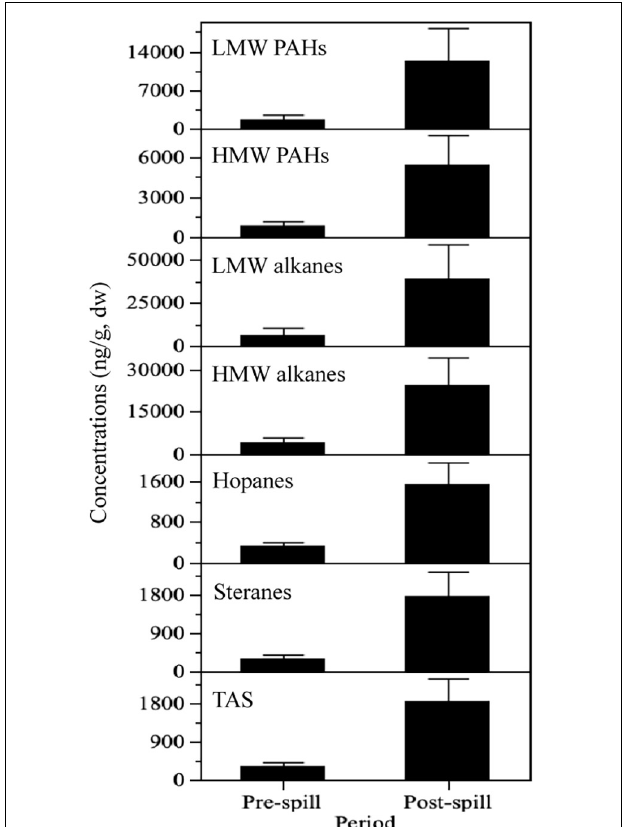
FIGURE 2 | Hydrocarbon concentrations (ng/g, dw) by periods from sediment samples collected in 2010–2011 in the nGoM. Post-pill denotes concentrations in surface sediments (top 1 cm layer in the sediment cores), and pre-spill indicate concentrations in downcore layers (1–3 cm layer). LMW PAHs: 2–3 rings, HMW PAHs: 4–6 rings, LMW alkanes: C12–C23 n -alkanes, HMW alkanes: C24–C37 n -alkanes, hopanes: C23–C35, steranes: C27–C29, and TAS: C26–C28. Data shown as mean ± 95% confidence